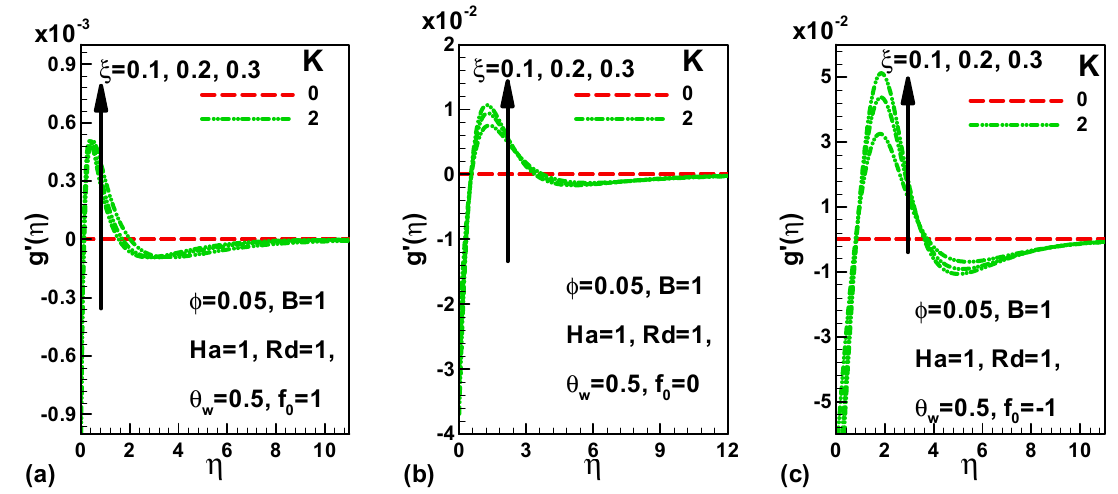
Figure 4. E ff ects of micropolar parameter on dimensionless rotating velocity along truncated cone for ( a ) suction, ( b ) impermeable, and ( c ) injection of kerosene-based magnetite nanofluid. Figures 5–7 exhibit the impacts of the magnetic parameter and the solid volume fraction of nanoparticles of Fe 3 O 4 on the dimensionless velocity, temperature, and rotating velocity, respectively. In the suction case, no appreciable impact of the magnetic parameter could be observed for the pure fluid ( φ = 0), Figure 5a. However, as the solid volume fraction of nanoparticles boosts, the impact of the magnetic parameter can be noticed. Due to the higher density of nanoparticles and Lorentz forces, the velocity of the fluid reduces to zero in the hydrodynamic boundary layer. The boundary-layer thickness depends upon the magnetic parameter as well as the solid volume fraction. The same behavior of the velocity profiles can be observed in the case of an impermeable surface, see Figure 5b. However, in this case, the hydraulic resistance will be more significant due to the larger boundary-layer thickness. Again, in the injection case, no visible e ff ect of the magnetic parameter could be observed for the pure fluid ( φ = 0), see Figure 5c. This e ff ect is more pronounced when the solid volume fraction increases. The qualitative behavior of velocity profiles is the same as in previous cases. However, the thickness of the hydrodynamic boundary-layer is found to be the largest in the case of injection.